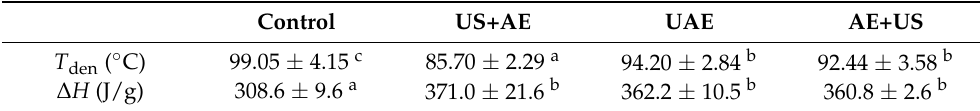
Table 4. Thermal properties of pumpkin seed protein isolates.